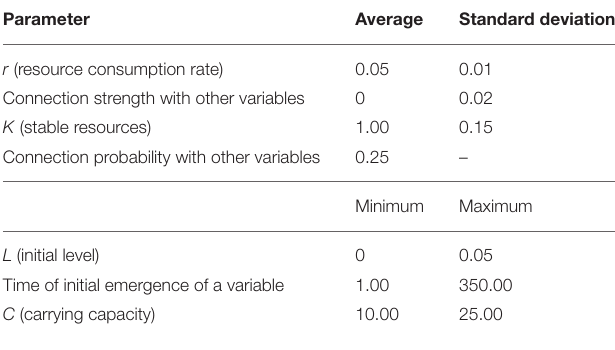
TABLE 1 | Default parameter values used for the dynamic model simulations. Parameter